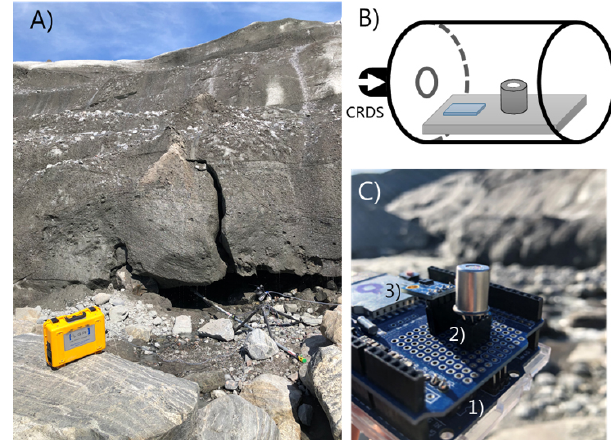
Figure 2. (a) Close-up of air-filled cavity below the Greenland ice sheet next to the lateral meltwater outlet. The aluminum pole ex- tends approximately 5m into the cavity and holds the common inlet tube and the temperature and humidity smart sensor. (b) Concep- tual diagram of the MOS system which was connected in series to the outlet port of the CRDS analyzer. (c) Close-up of the board- mounted MOS and temperature–humidity micro-sensor. The MOS system consisted of (1) a microcontroller, (2) datalogger shield holding metal oxide CH 4 sensor, and (3) an additional temperature– relative humidity